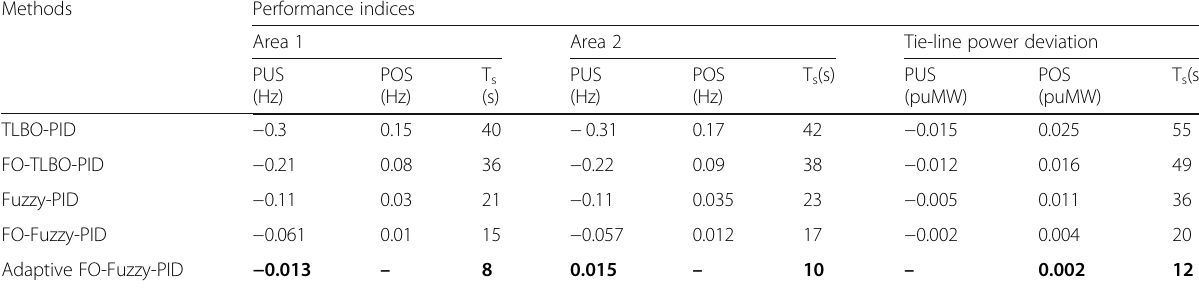
Table 5 Comparative study of various controllers for scenario